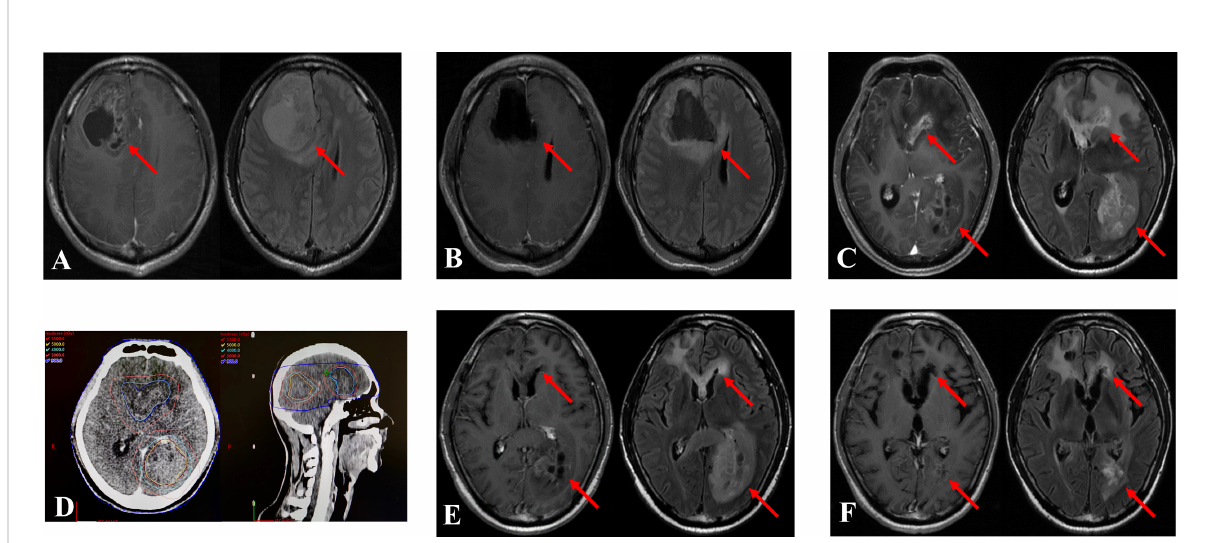
FIGURE 1 Treatment case of re-irradiation therapy. The two recurrent tumors were diagnosed in a 39-year-old man 13.1 months after the initial operation. The patient underwent re-irradiation of 40 Gy in 20 fractions at in situ focus and 50 Gy in 25 fractions at distant locus. (A) : Magnetic resonance imaging (MRI) at initial diagnosis. Left: T1 enhanced MRI, Right: T2 fl uid enhanced MRI. (B) : MRI after the operation. (C) : MRI at recurrence. (D) : Re-irradiation treatment plan. (E) : MRI after re-irradiation. (F) : MRI 6 months after re-irradiation. The arrow indicates the tumor